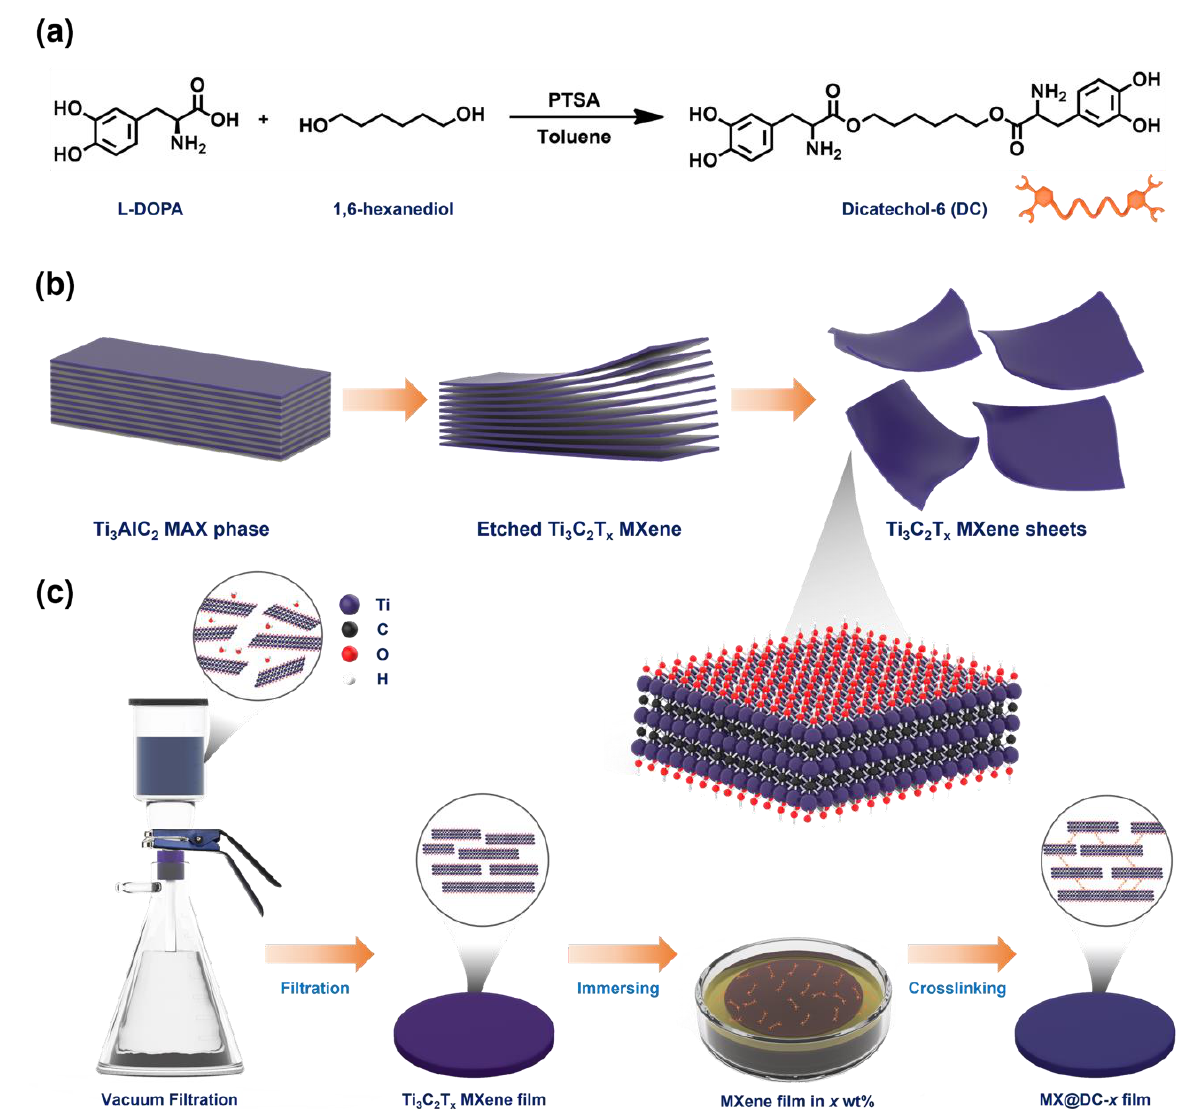
Figure 1. Schematic of ( a ) synthesis of DC, ( b ) fabrication of MXene, and ( c ) crosslinking MX@DC − x films.